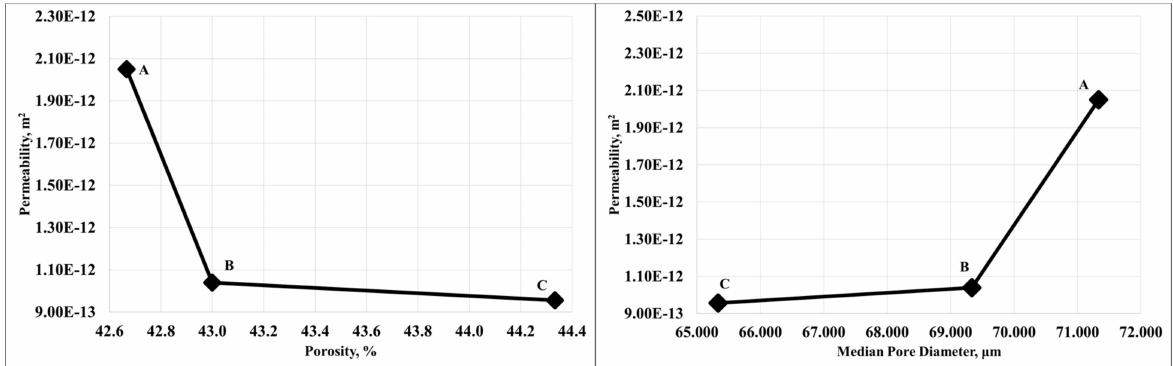
Figure 9. ( a ). Permeability as a function of the median pore diameter. ( b ) Permeability as a function of the total